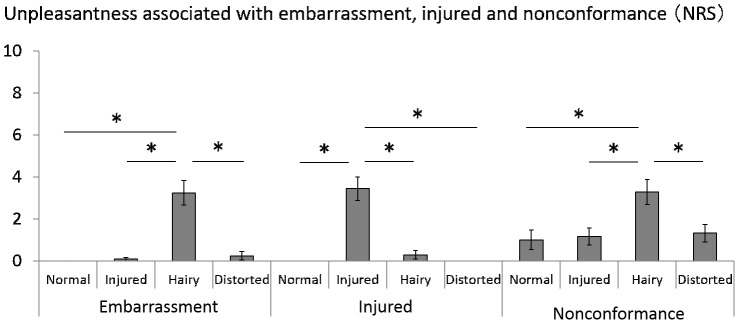
Unpleasantness associated with embarrassment, injury and nonconformance (NRS) under each condition.The post-hoc test showed that the hairy condition had a significantly greater impact than the normal, injured and distorted conditions for the item of unpleasantness associated with embarrassment. The post-hoc test showed that the injured condition had a significantly greater impact than normal, hairy and distorted conditions for the item of unpleasantness associated with injury while the hairy condition had a significantly greater impact than normal, injured and distorted conditions for unpleasantness associated with embarrassment. Error bars indicate ± SE. * p<0.0083.